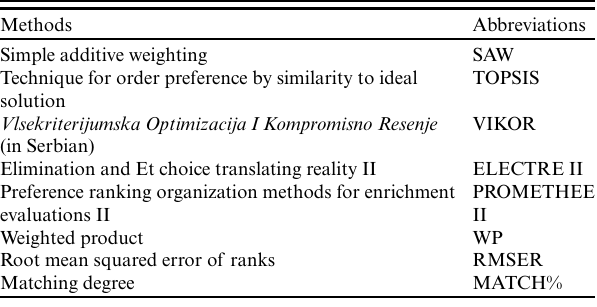
Table 2 . Abbreviations of the various